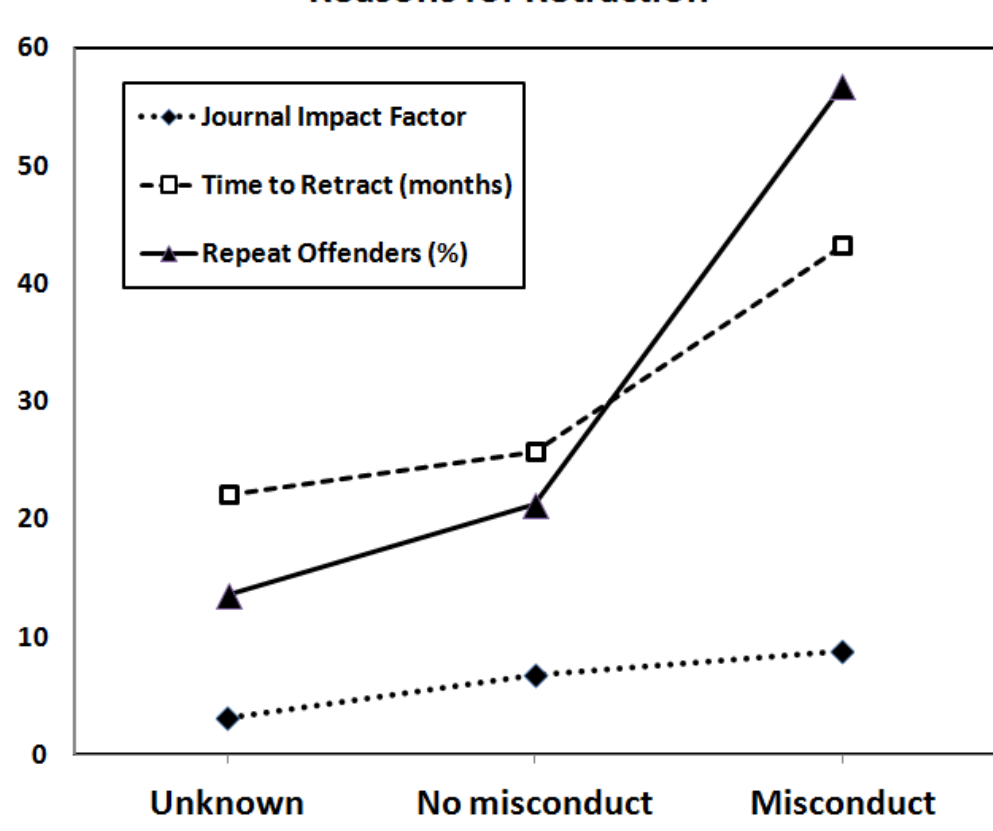
Figure 1. Comparison of parameters for papers retracted for “Unknown” reasons to papers retracted for either “Misconduct” or “No misconduct”; all points shown are averages. Papers retracted for “Unknown” reasons ( n = 178) are more similar to papers retracted